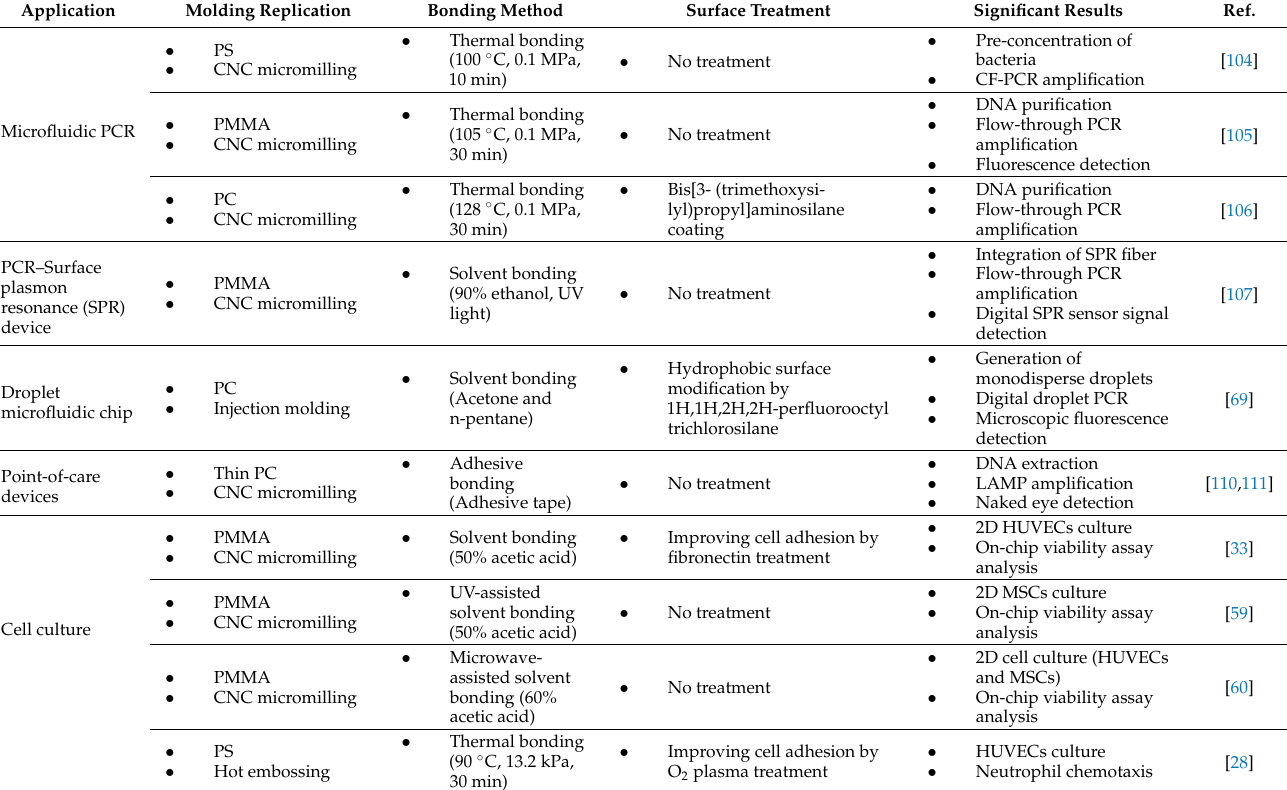
Table 2. Representative thermoplastic bonding strategies and